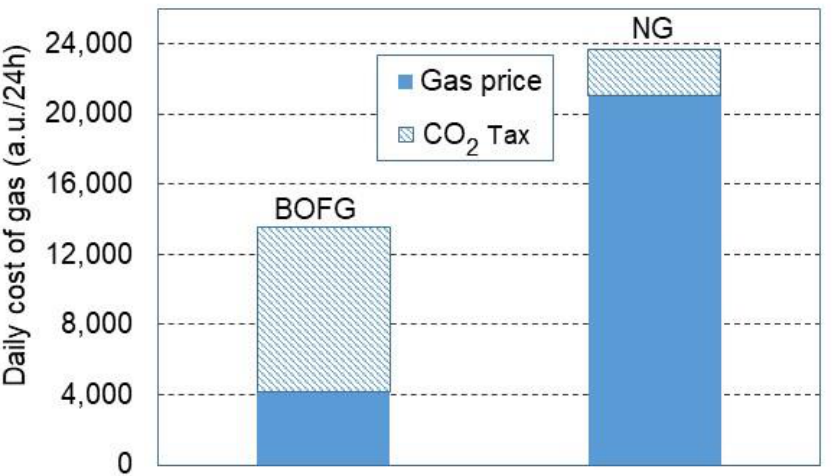
Figure 8. Daily cost of purchasing NG and BOFG including a carbon tax, net price, and total price. The potential savings for a factory can be generated on the basis of the cheaper